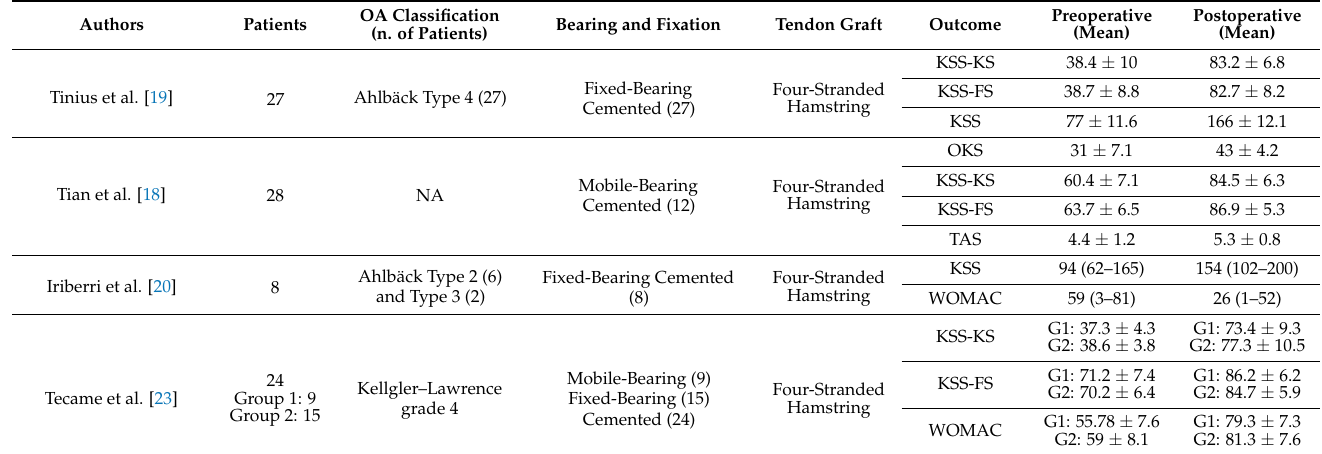
Table 2. Functional outcomes and surgical technique